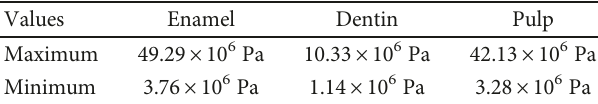
Table 5: 2nd degree caries : von Mises stresses results. Values